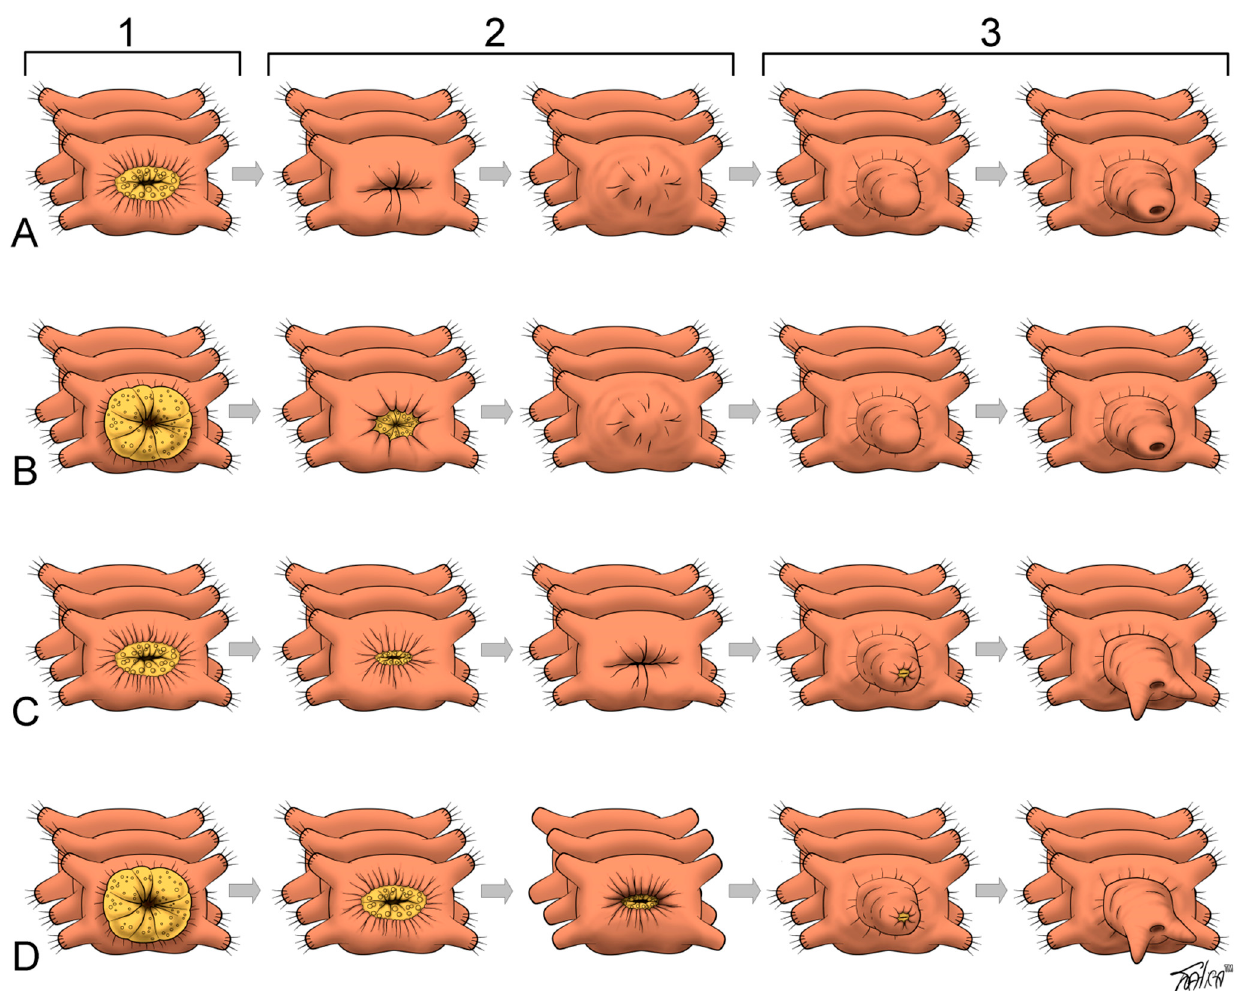
Figure 1. Variability and staging of large-scale regeneration events in annelids after anterior ( A , B ) or posterior ( C , D ) amputation. The schemes illustrate changes at the amputation site (an intersegmental transverse cut). ( A , B ) Variants of complete closure of the gut opening by the wound epithelium. Oral or anal opening forms by an independent invagination of the superficial epithelium. These variants are characteristic of the anterior regeneration in all annelids tested as well as of the posterior regeneration in oligochaetes and most polychaetes. ( C , D ) During the “open regeneration”, the intestinal epithelium joins the epidermis, so that the gut lumen is always connected to the external environment. These variants are characteristic of the posterior regeneration in some polychaetes, such as nereids, sabellids, Harmothoe , and Nephtys . Column (1), an immediate response to amputation: primary wound closure is ensured by ( A , C ) constriction of circular muscles, which may be accompanied by ( B , D ) intestinal protrusion (yellow), forming a primary wound-plug. Column (2), stages of epithelialization and blastema initiation. Column (3), growth and differentiation of regenerative bud. The horn-like structures in ( C , D ) illustrate formation of pygidial cirri, as seen in nereids (Figure 4D).